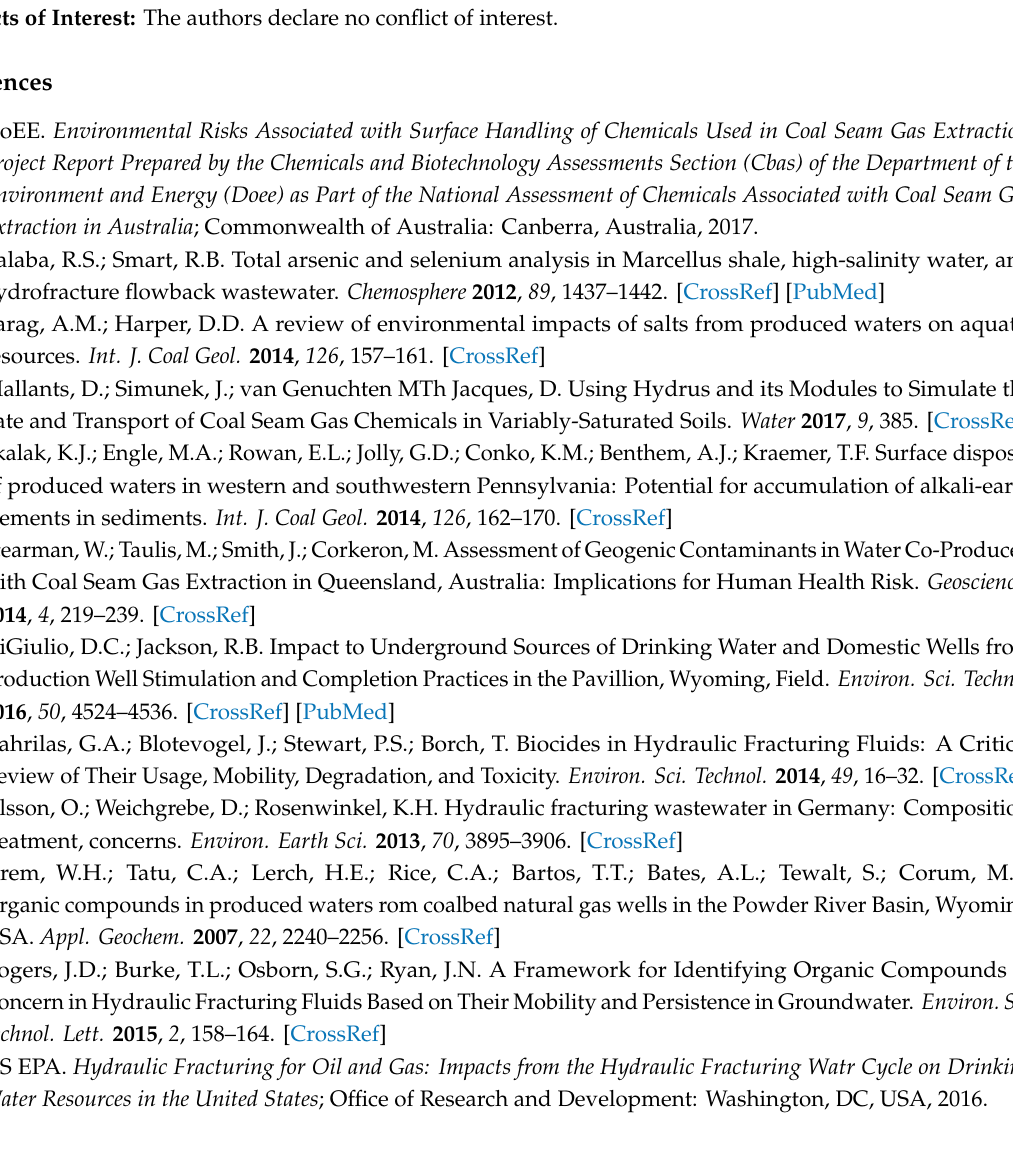
Figure S1: Depth to water table within the alluvial groundwater modelling domains. Source: [1]. Table S1: Major soil types in the Namoi alluvium (areal coverage was derived with the ARCGISTM software). Source [1]. Table S2: Soil depth expressed as depth to groundwater based on the site groundwater flow model (24 km 2 ). Table S3: Soil depth expressed as depth to groundwater based on the sub-regional groundwater flow model (108 km 2